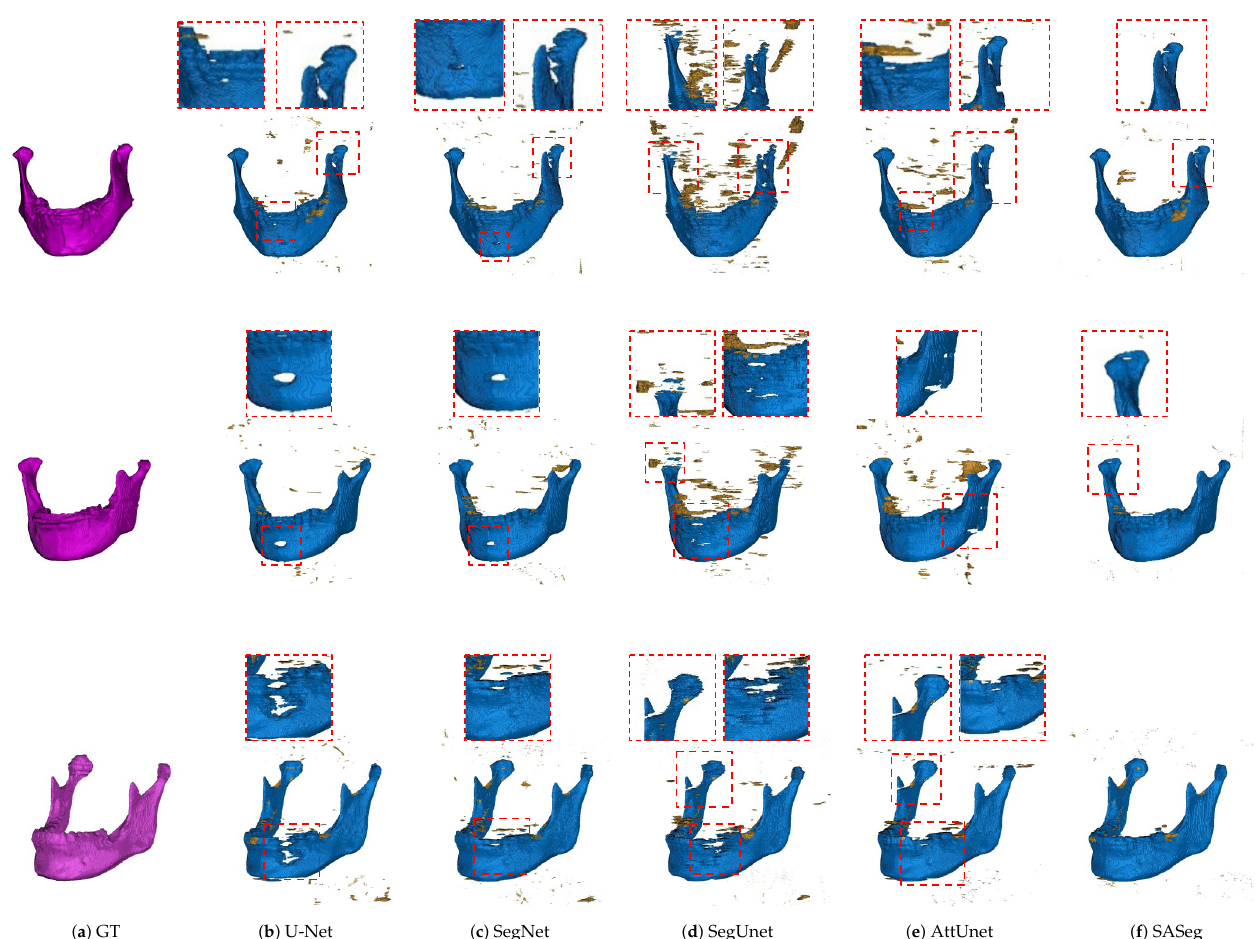
Figure 6. Results with the fashionable segmentation approaches. The ground truth is shown in the column ( a ). Columns ( b – f ) show the mandible predictions generated by the U-Net, SegNet, SegUnet, AttUnet, and the proposed SASeg, respectively. The red rectangle indicates the zoom-in views of bad